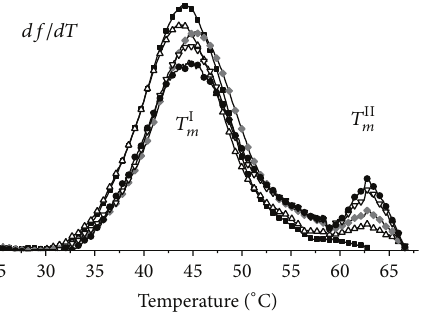
Figure 2: The first derivative of the melting curves 𝑑𝑓/𝑑𝑇 of DNA in the complexes with HMGB1 at different protein to DNA ratios 𝑟 (w/w): ◼ : 𝑟 = 0 (DNA); 󳵻 : 𝑟 = 0.15 ; X : 𝑟 = 0.25 ; 󳶋 : 𝑟 = 0.4 ; e : 𝑟 = 0.5 . All curves were obtained in 0.25 mM EDTA/0.2 mM NaCl solution.